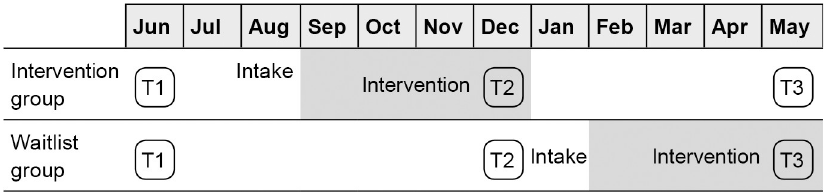
Fig 1. Participant flow chart. n = number of children, T1 = measurement 1, T2 = measurement 2, T3 = Measurement 3, CDI = Child Depression Inventory, CBSK = The Dutch version of the Self-Perception Profile for